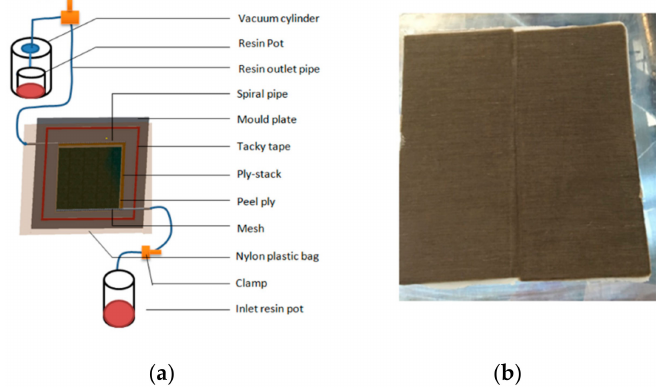
Figure 2. ( a ) Vacuum resin infusion process used for manufacturing composites; and ( b ) fabricated cross-laminated flax fiber tape